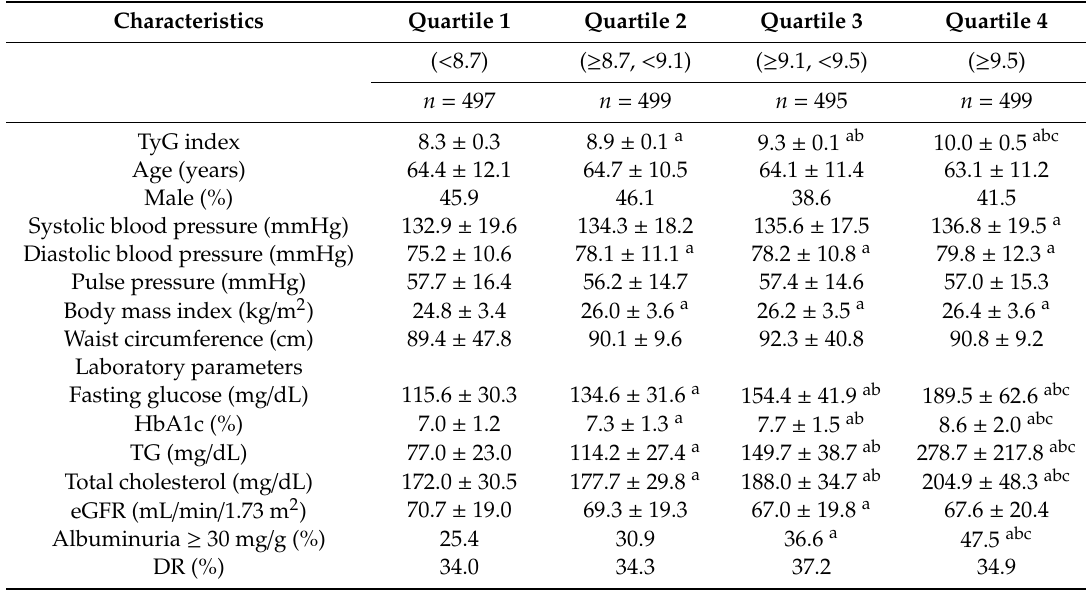
Table 1. Comparison of Baseline Characteristics According to TyG index